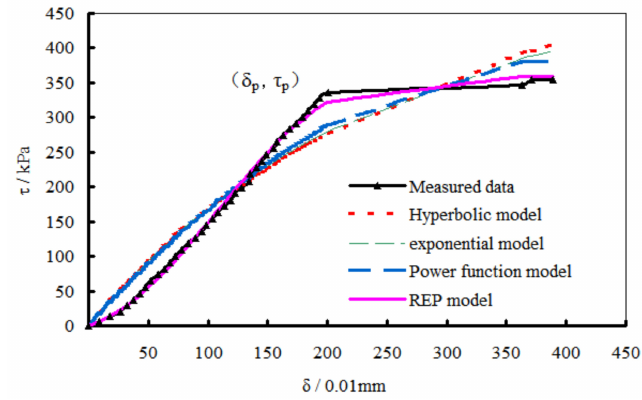
Figure 7. τ - δ curve for mix ratio with 10% (cid:24) Nm content.